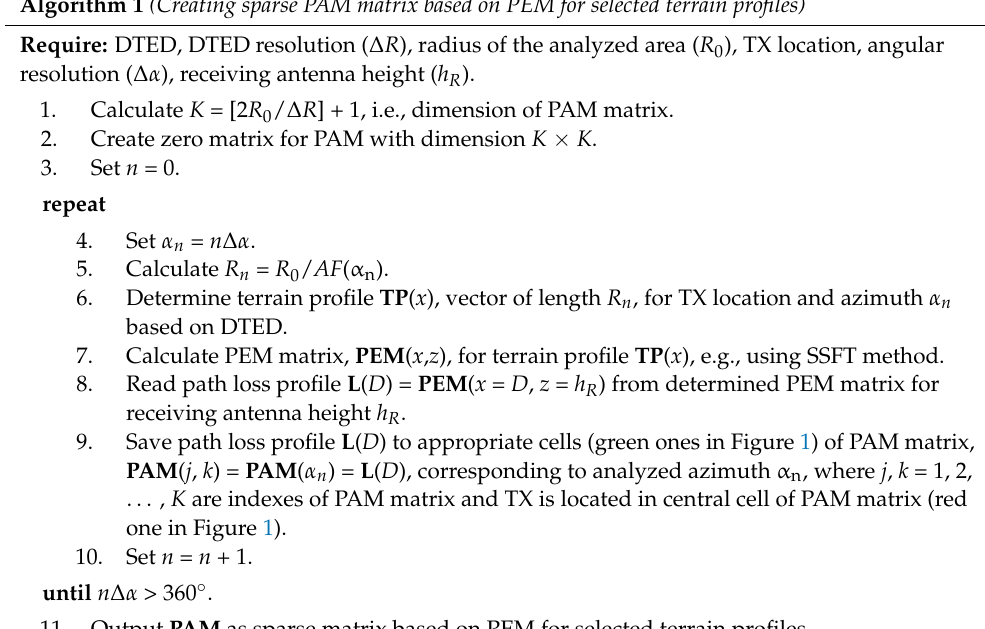
Algorithm 1 (Creating sparse PAM matrix based on PEM for selected terrain